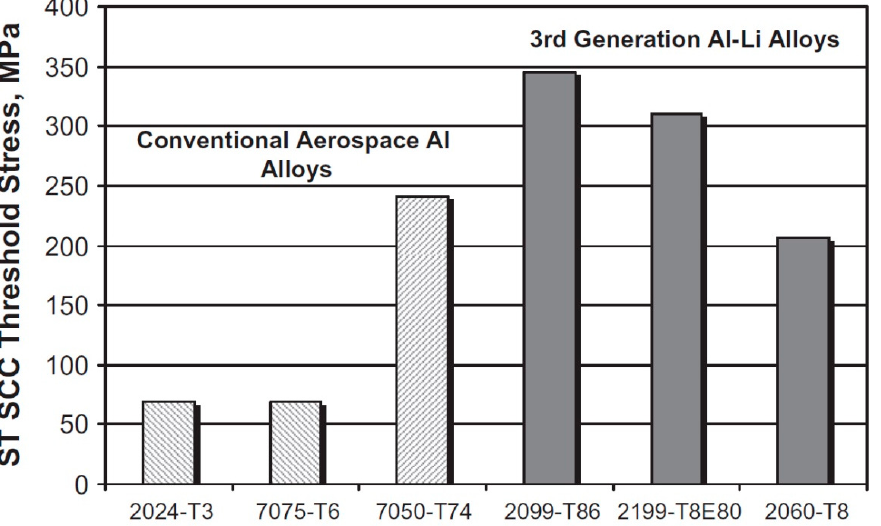
Figure 9. Comparison of corrosion resistance of Al-Li alloys with 2000 and 7000 series alloys. (reprinted with the permission of Tolga Dursun [39] and with permission of Elsevier).